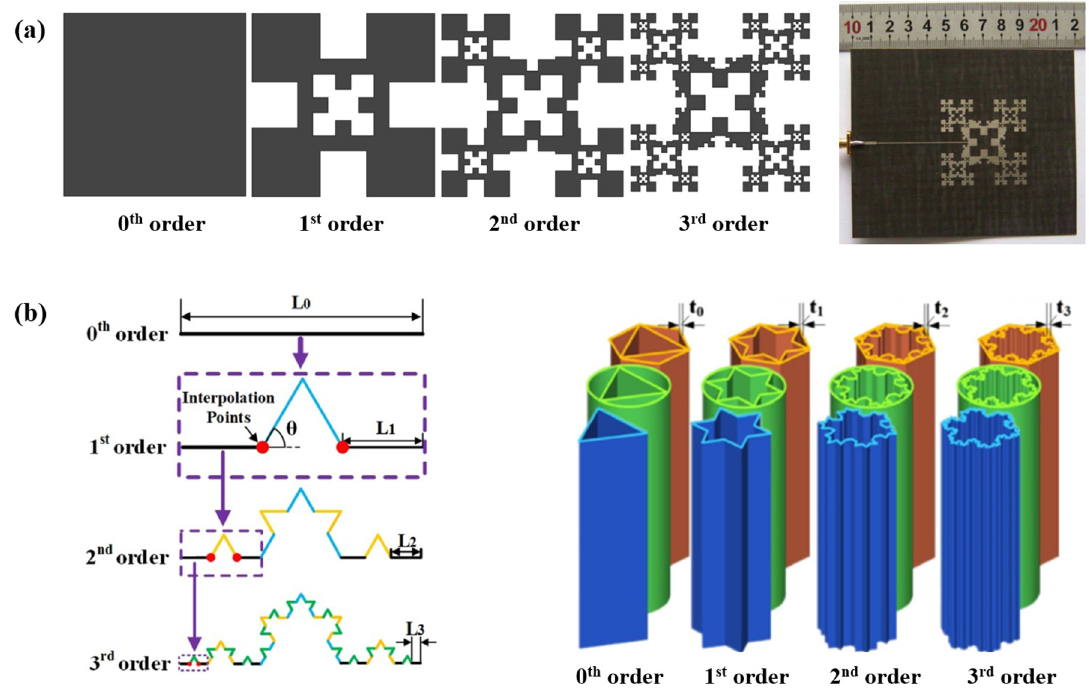
Figure 1. ( a ) Koch and Sierpinski patterns inspired antenna design [9], reproduced courtesy of The Electromagnetics Academy; ( b ) Koch snowflake inspired thin-walled structure design for energy absorption [51].